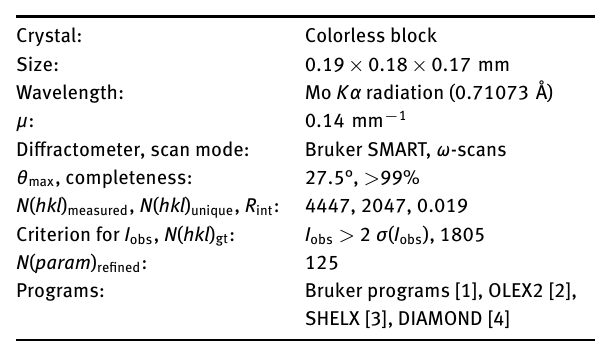
Table 1: Data collection and handling.